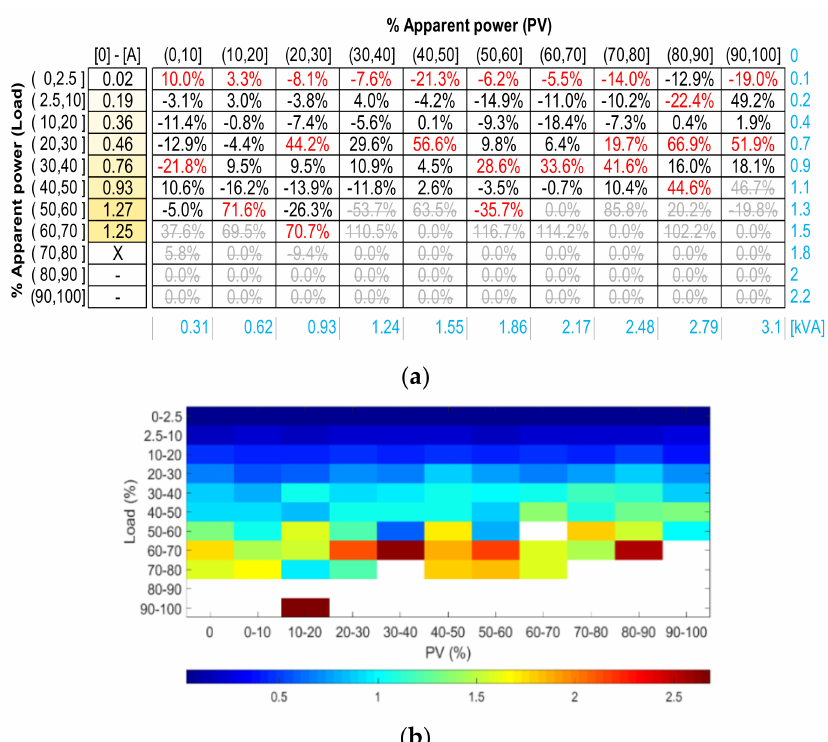
Figure 22. Behaviour of IH3: ( a ) matrix of IH3 values for PVS Of f scenarios and variations of IH3 values for PVS On scenarios of Phase A, and ( b ) average value per scenario.